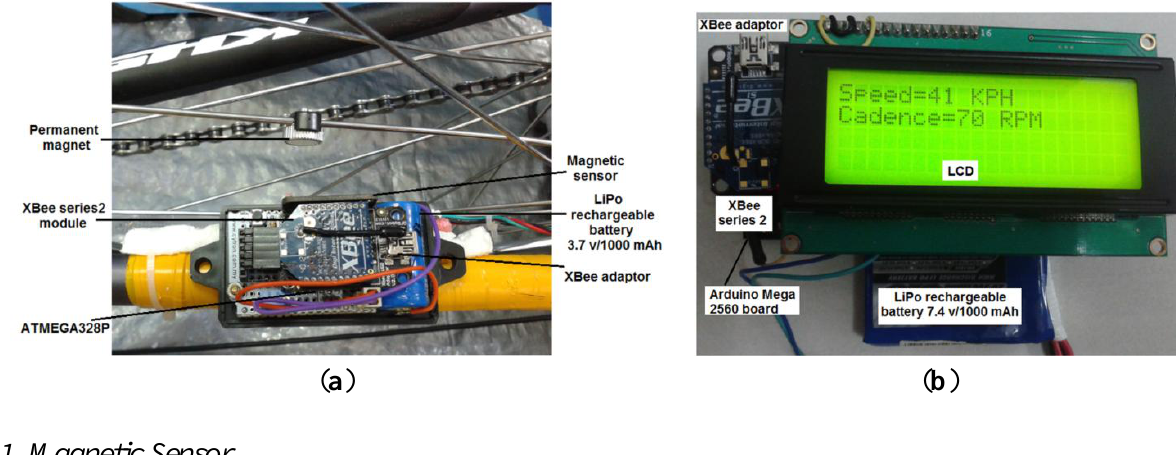
Figure 2. A snapshot of the full framework: ( a ) sensor node with its parts mounted on bike chainstays and ( b ) the coordinator node with its parts mounted on the seat post under the rider seat